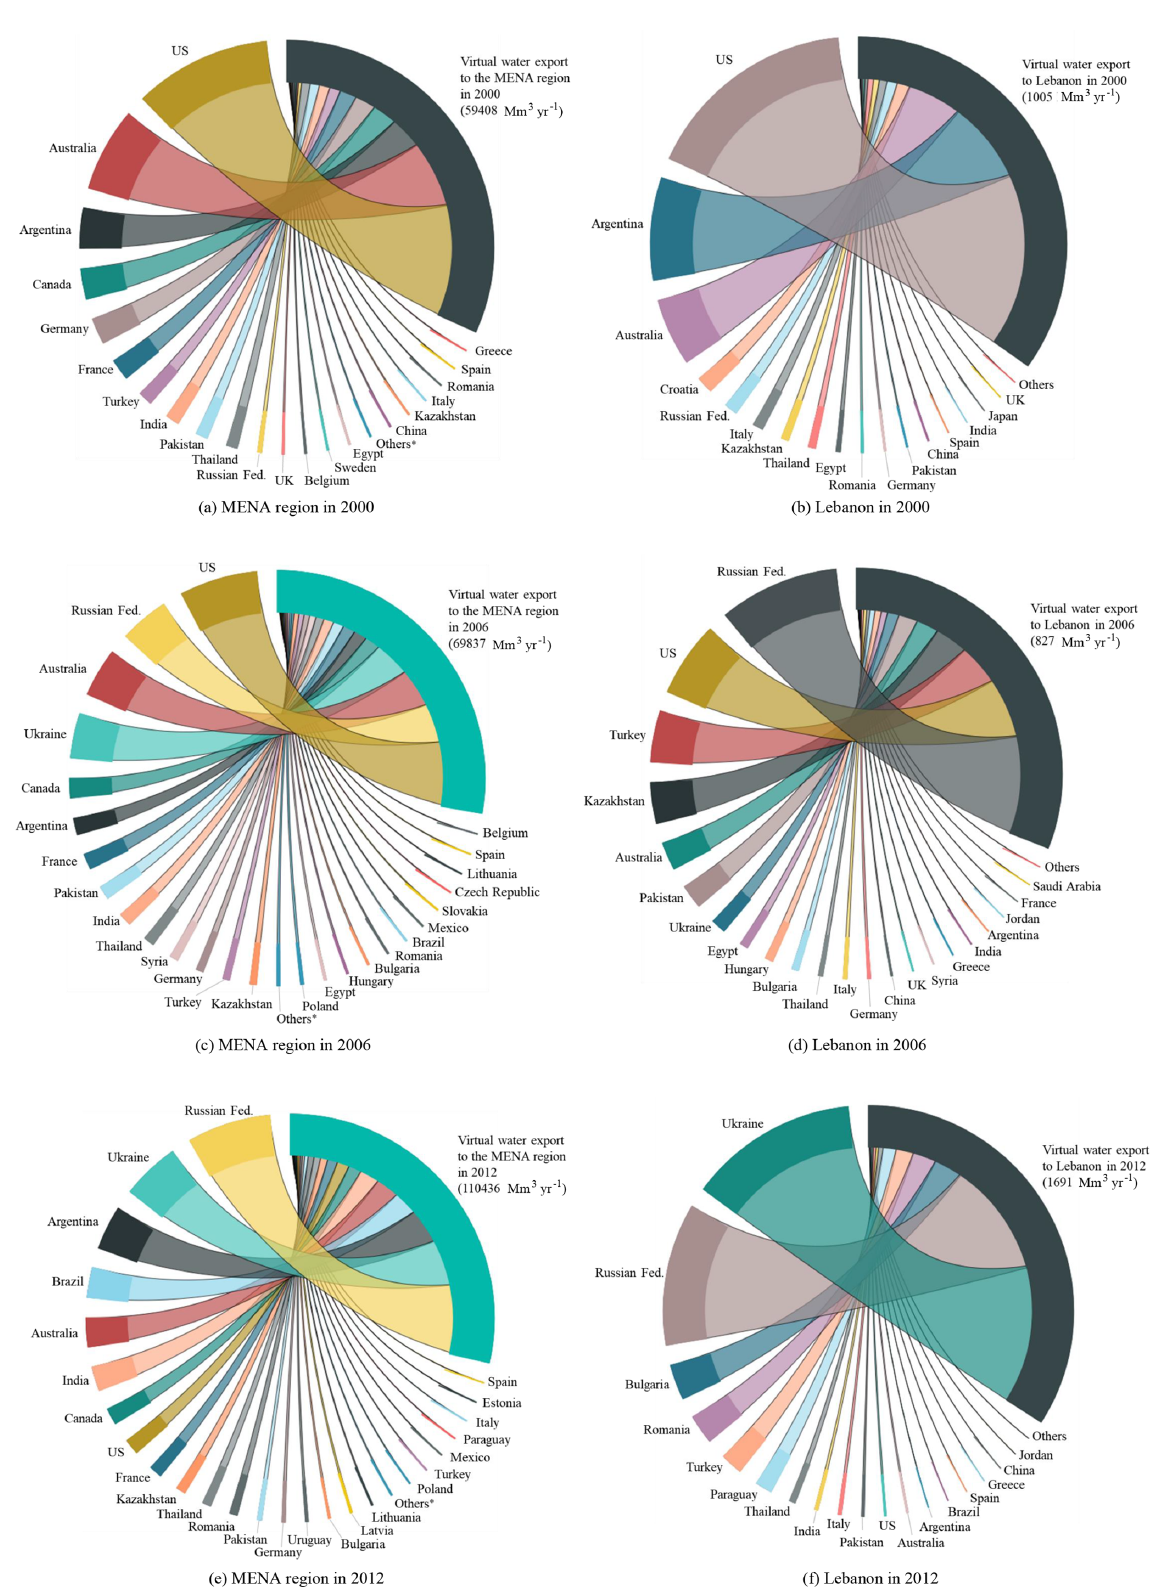
Figure 4. Virtual water imports at the MENA region and Lebanon in 2000, 2006, and 2012. Others indicate the countries which export less than 100Mm 3 yr − 1 to the MENA region or